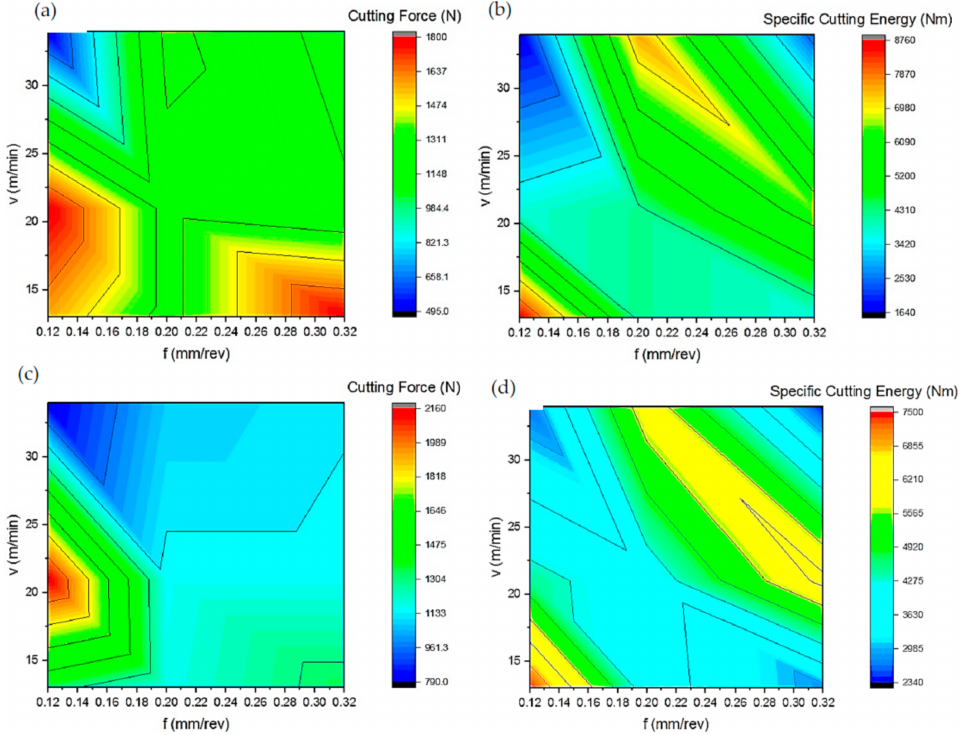
Figure 3. Contour maps of cutting force and specific cutting energy versus feed rate and cutting speed for ( a , b ) AISI 304 and ( c , d ) AISI 2205 stainless